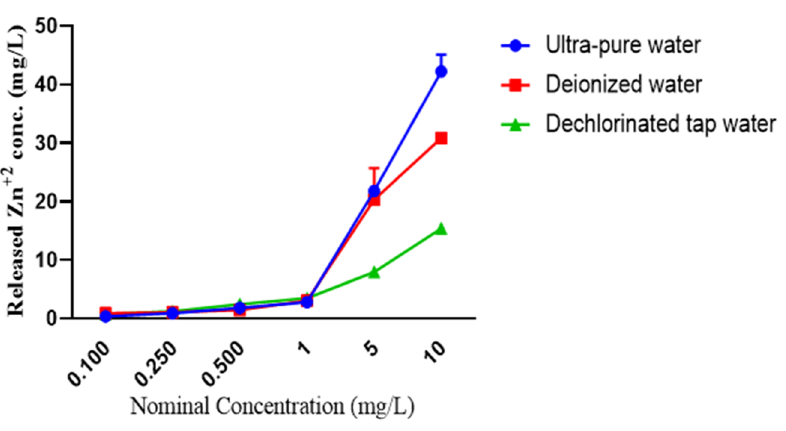
Figure 2. The concentrations of released Zn 2+ from ZnO NPs in ultra-pure water, deionized water, and dechlorinated tap water.